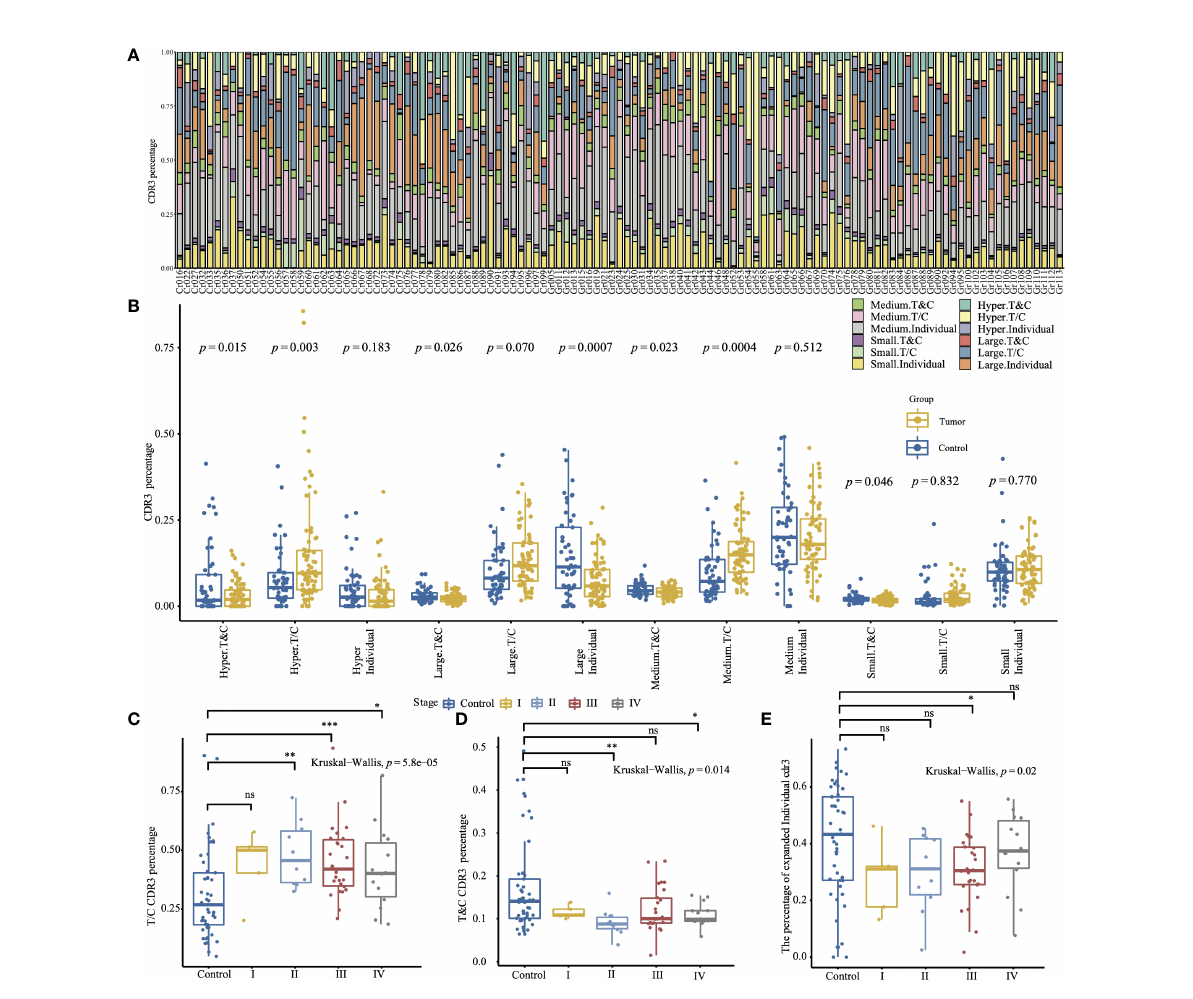
FIGURE 1 The relative abundance with speci fi c frequencies of the different CDR3 groups is based on the shared CDR3 between the tumor group and the healthy control group. (A) The CDR3 percentage of different groups in all samples. (B) The comparison of the CDR3 percentage of different groups between the tumor and the control group (two-sided t -test). (C) Comparison of T/C CDR3 percentage between the control group and sub-tumor group of different tumor stages. (D) Comparison of T&C CDR3 percentage between the control group and sub-tumor group of different tumor stages. (E) Comparison of expanded individual CDR3 percentage between the control group and sub-tumor group of different tumor stages. (The convention for symbols indicating statistical signi fi cance, ns: p > 0.05; * p ≤ 0.05; ** p ≤ 0.01; *** p ≤ 0.001. The two-sided Wilcox test was used for two-group comparison, and the Kruskal – Wallis test was used for comparing more